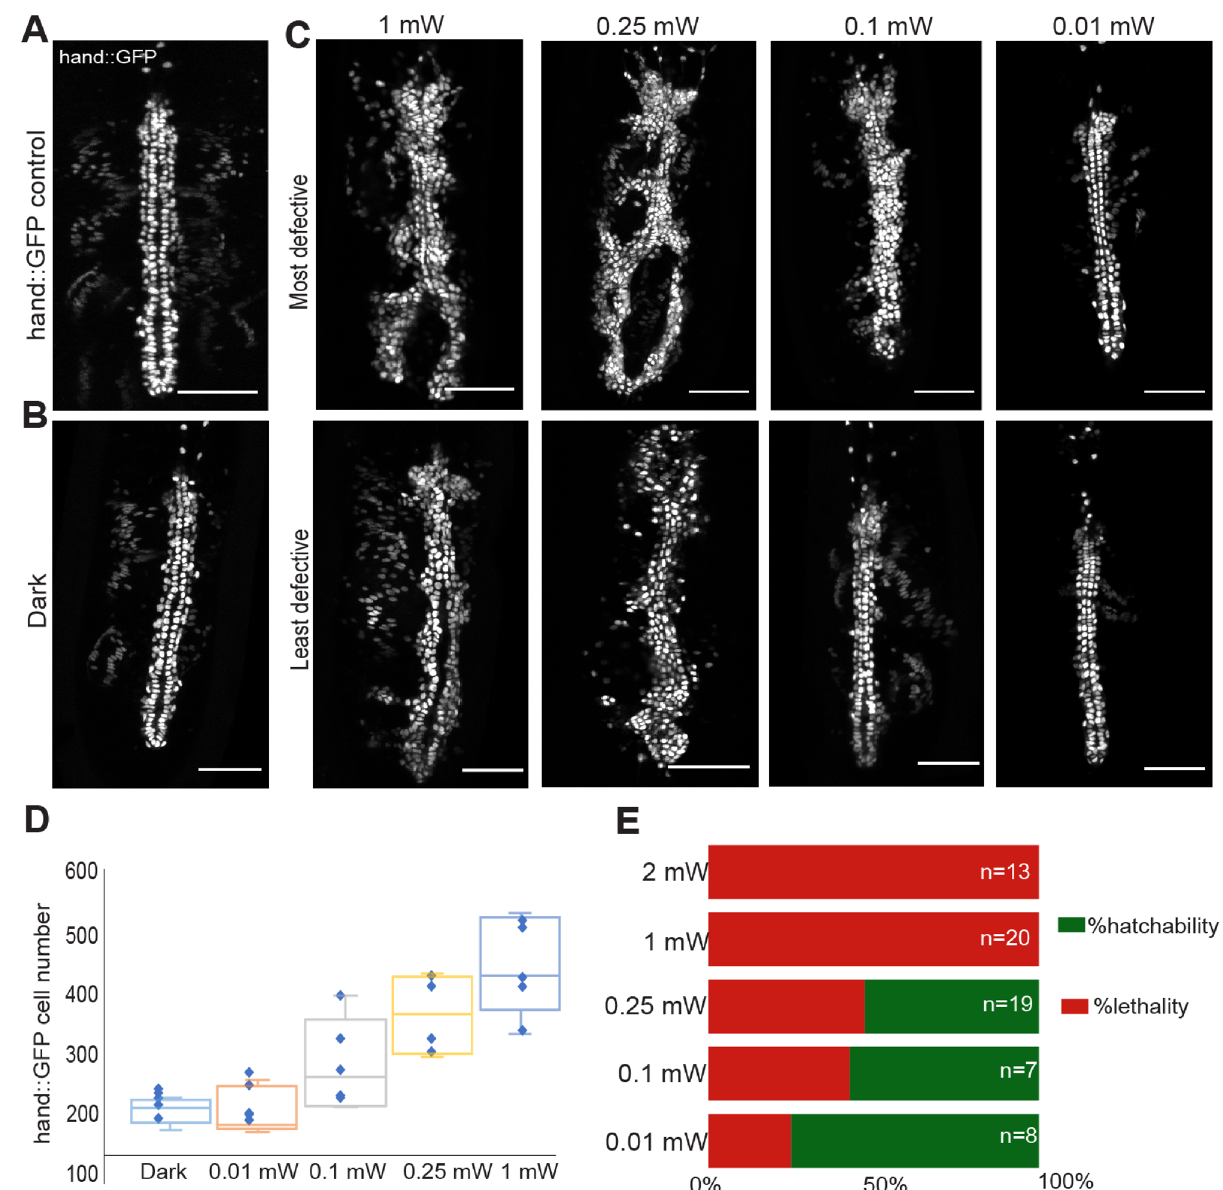
Figure 5. Opto-htl induced phenotype depends on light intensity. ( A ) Heart at stage 16 in a hand ::GFP control embryo. ( B ) Heart at stage 16 in a twi ::Gal4 > hand ::GFP;Opto-htl embryo kept in the dark throughout development. ( C ) Representative images of the heart at stage 16 in twi ::Gal4 > hand ::GFP;Opto-htl embryos illuminated from stage 5 till stage 16, at different light intensities. ( D ) Quantification of hand :GFP cell number for embryos illuminated at different intensities (n = 5 for each condition). The top and bottom of the box represent the third quartile and the first quartile, respectively. The median divides the box. The whiskers are error bars: upward from the third quartile to the maximum, and downward from the first quartile to the minimum. ( E ) Survival rate of twi ::Gal4 > Opto-htl embryos when illuminated at different intensities throughout development. Scale bar = 50